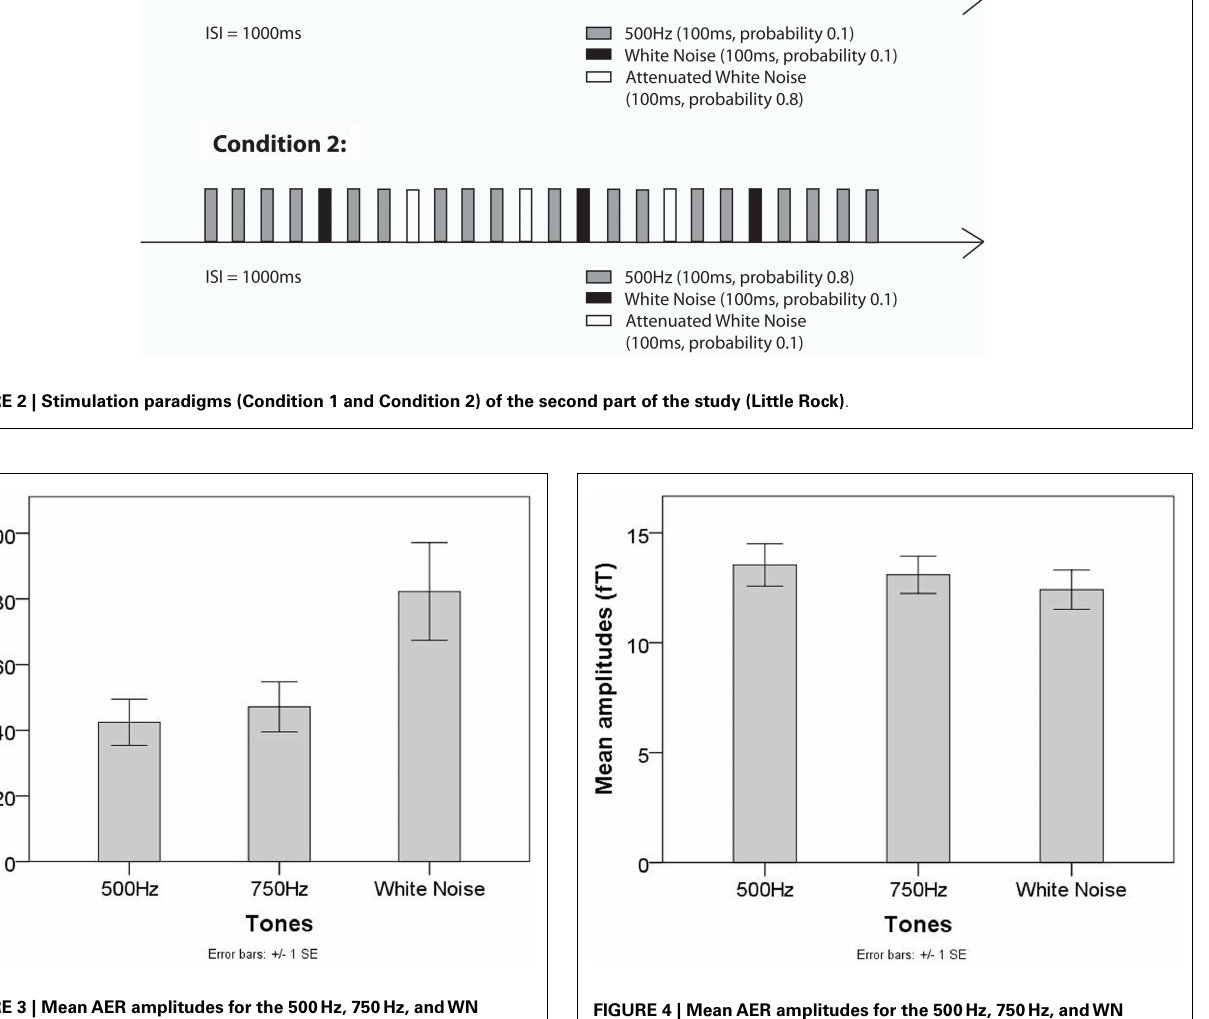
the median amplitudes of the AERs to the WN and those to the second condition ( Z = 2.02, p <